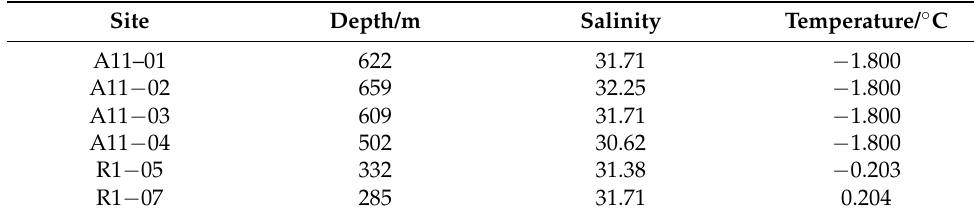
Figure 1. Sampling sites in the AS and RS: ( a ) overall map; ( b ) local map. Table 1. The environmental information of the six sites.